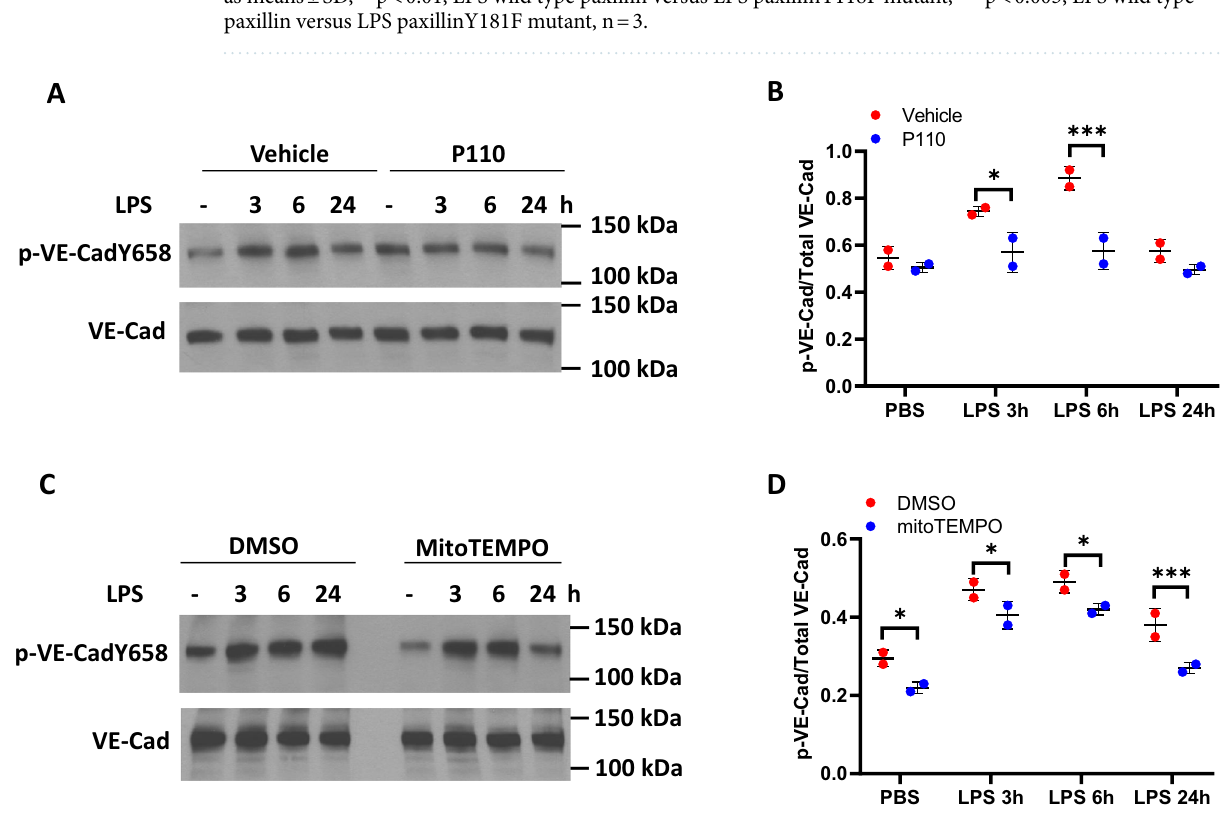
Figure 8. Inhibition of mitochondrial ROS dampens LPS-induced VE-Cadherin phosphorylation. HLMVECs were pretreated with P110 ( A ) or MitoTEMPO ( C ) to block mitochondrial ROS, cells were then treated with LPS for various time points. Phosphorylation of VE-Cadherin at Y658 was detected by Western blot. Two independent experiments were performed. ( B , D ) Results of quantitative analysis are shown as intensity ratio of phosphorylated VE-Cadherin to total VE-Cadherin. Values are means ± SD of 2 independent experiments. *p < 0.05, vehicle versus P110 for 3 h of LPS treatment ( B ) and vehicle versus MitoTEMPO for 3 h and 6 h ( D ) of LPS treatment; ***p < 0.005, vehicle versus P110 for 6 h of LPS treatment ( B ) and vehicle versus MitoTEMPO for 24 h of LPS treatment ( D